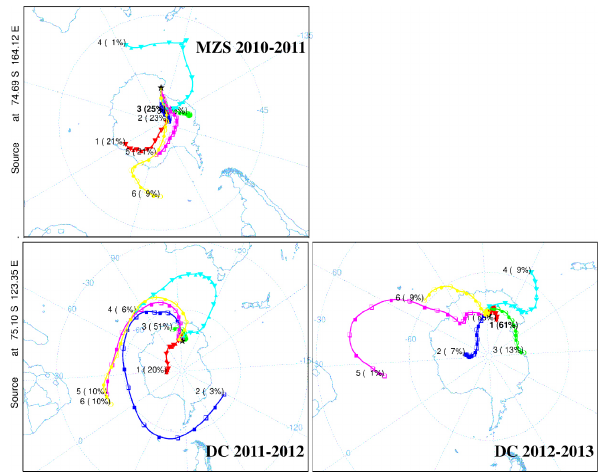
Figure 4. Distribution of chlorophyll concentrations in the Ross Sea for each sampling period obtained through the Aqua/MODIS NASA